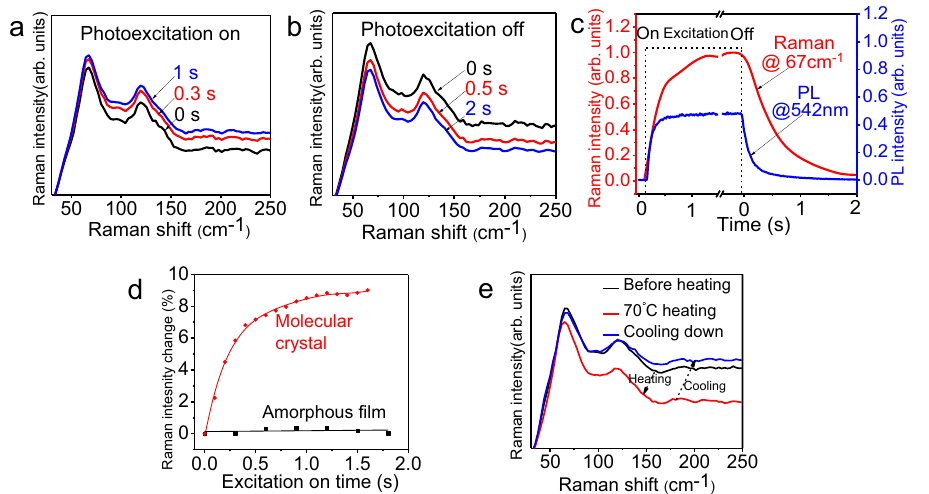
Fig. 5 Photoexcitation-assisted Raman characterizations upon applying/removing 375 nm excitation (785 nm laser beam for Raman). a Raman spectra measured at different illumination times after applying 375 nm laser excitation. b Raman spectra measured at different times after removing 375 nm laser excitation. c Raman signal intensity at 67 cm − 1 and PL intensity at 542 nm plotted as a function of time upon applying/removing 375 nm laser excitation. d Raman signal intensity of molecular crystal at 67 cm − 1 and amorphous fi lm at 59 cm − 1 plotted as a function of time upon applying/removing 375 nm laser excitation. e . Raman spectra measured with heating to 70 °C and cooling down to room temperature